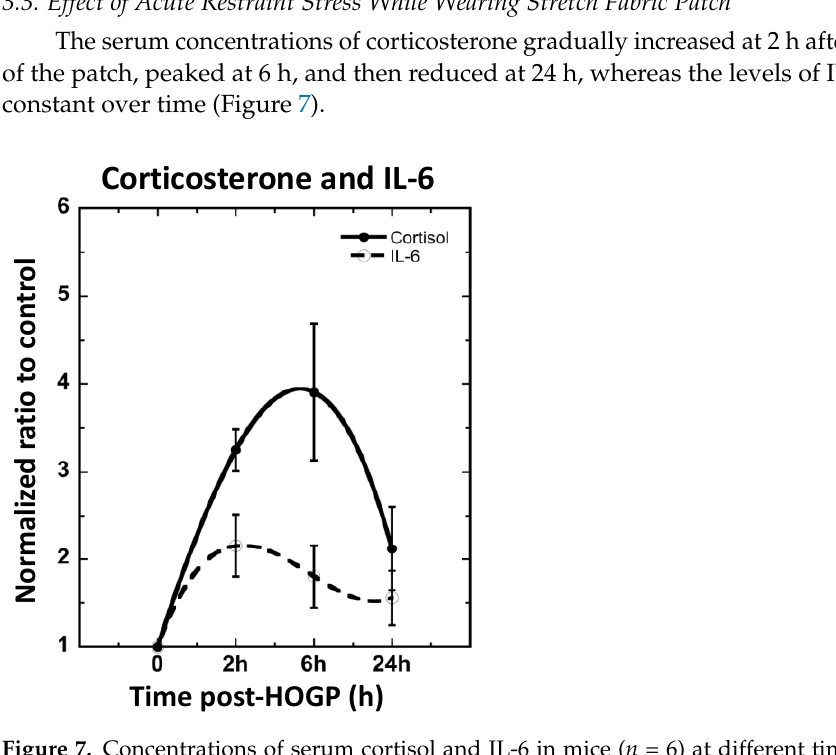
Figure 7. Concentrations of serum cortisol and IL-6 in mice ( n = 6) at different time-points post- application of the HOGP. Significant differences were identified using t -tests ( p < 0.05).